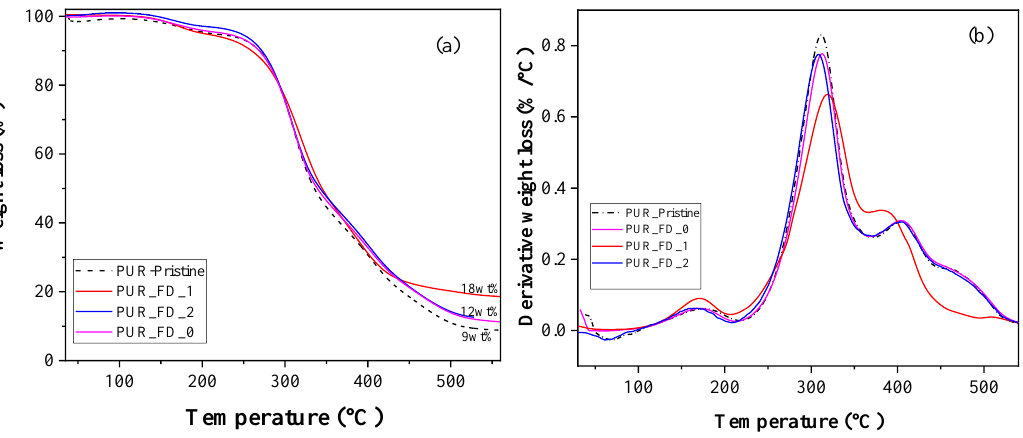
Figure 7. Thermogravimetric analysis (TGA) of the selected PUR foams. ( a ) TGA curves. ( b ) DTGA curves of the selected foams.